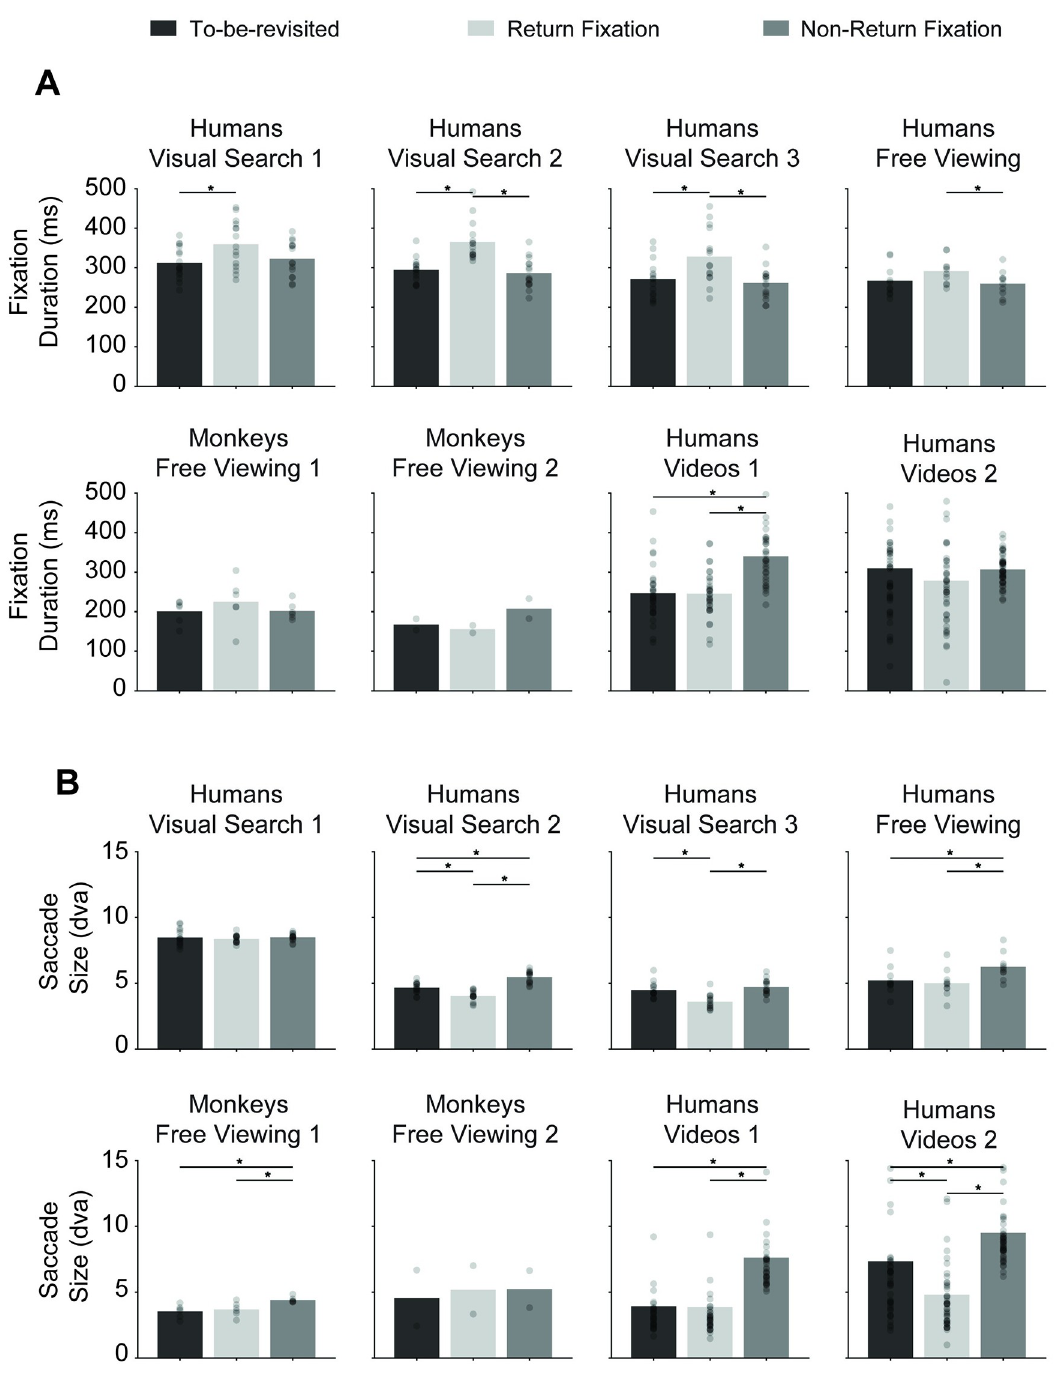
Fig 4. Return fixations tended to last longer and follow smaller saccades. ( A ) Duration of fixations in non-return fixation locations (dark gray), to-be-revisited locations (black), and return fixation locations (light gray). Dots show individual subjects. Error bars denote SEM. � denotes p < 0.05, two-tailed t-test. The durations of return fixations tended to be longer for return fixation locations in visual search tasks (see S24 Fig for fixation duration analysis separating target and non-target locations during visual search. ( B ) Saccade size (same format as A ). Return fixations tended to follow smaller saccades.